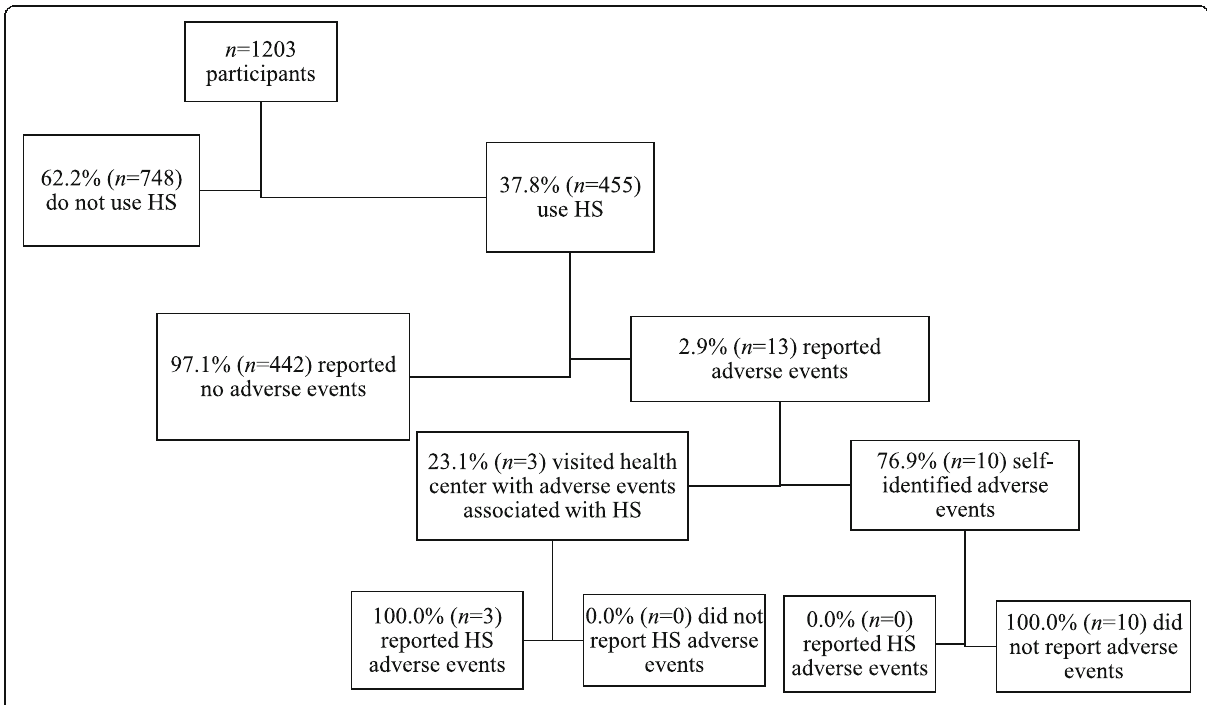
Fig. 2 Flow of participants with adverse